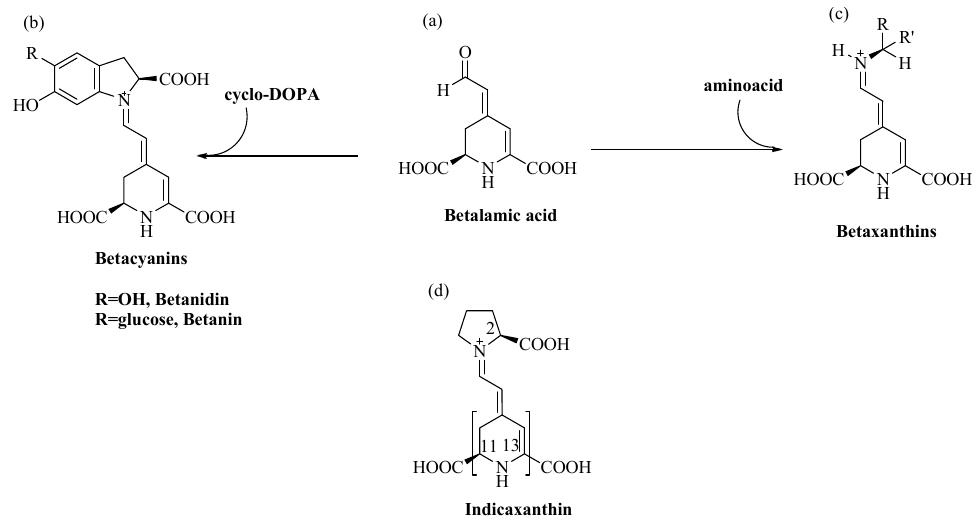
Figure 1. Structure of ( a ) Betalamic acid, ( b ) Betacyanins, ( c ) Betaxanthins and ( d ) Indicaxanthin (in brackets, parts with lipophilic character).